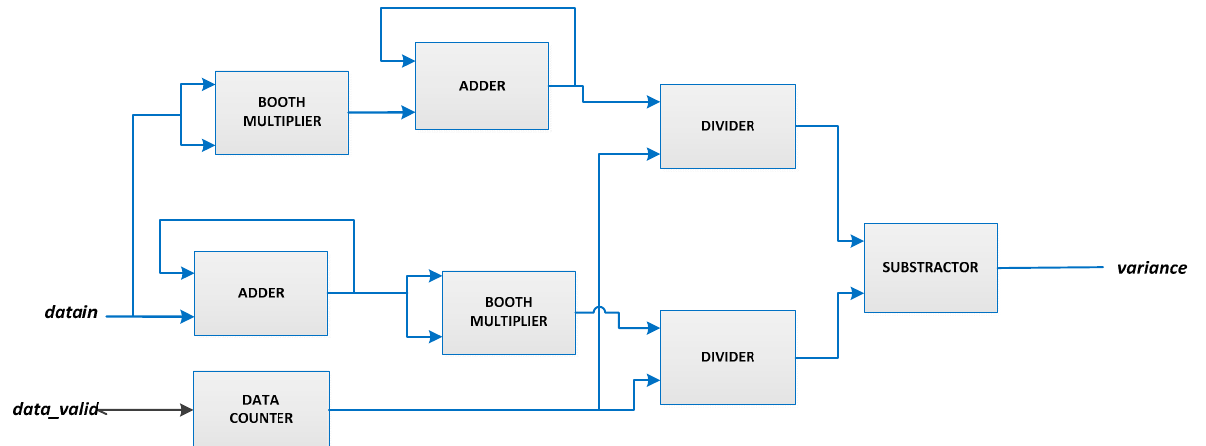
Figure 4. Variance calculation block implemented on the proposed system, designed to be able run on the real-time application.